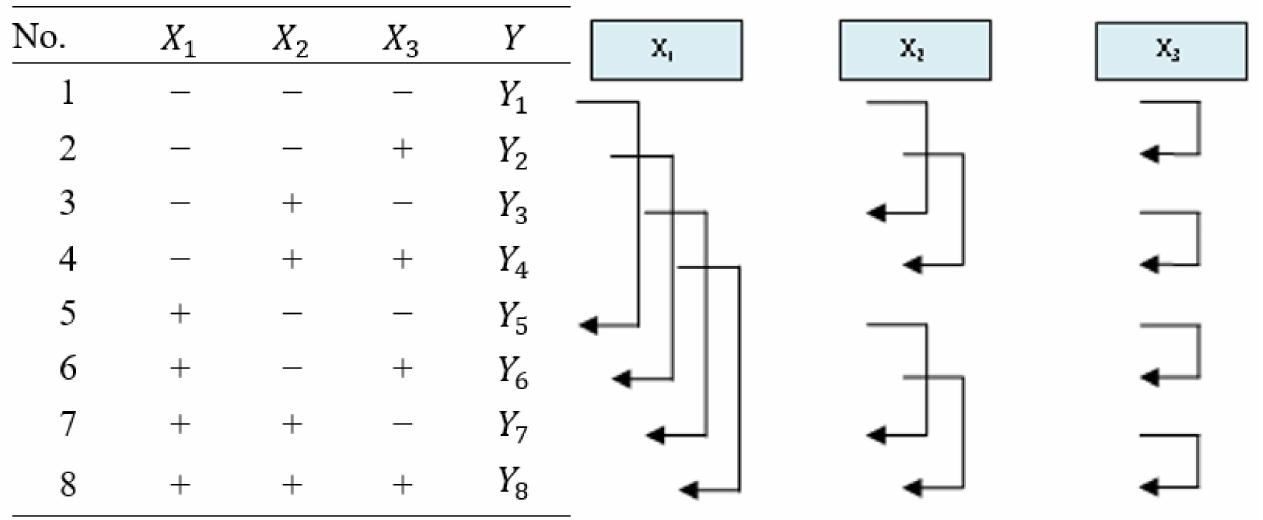
Figure 2. The assessment of the effect of each parameter, X 1 , X 2 , and X 3 , for the designed three- parameter two-level